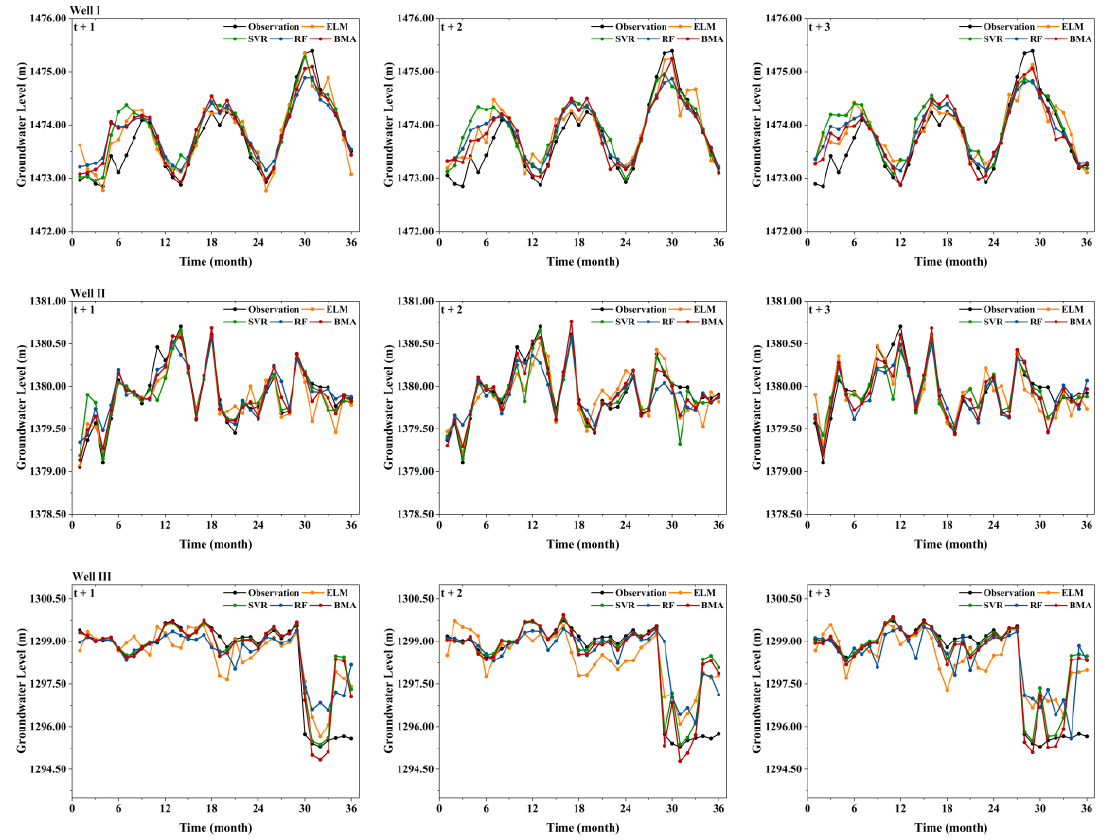
Figure 2. Hydrograph of the observed and predicted GWL obtained by the ELM, SVR, RF, and BMA models for Wells I, II, and III at 1-, 2-, and 3-month-ahead prediction horizons in the testing period.